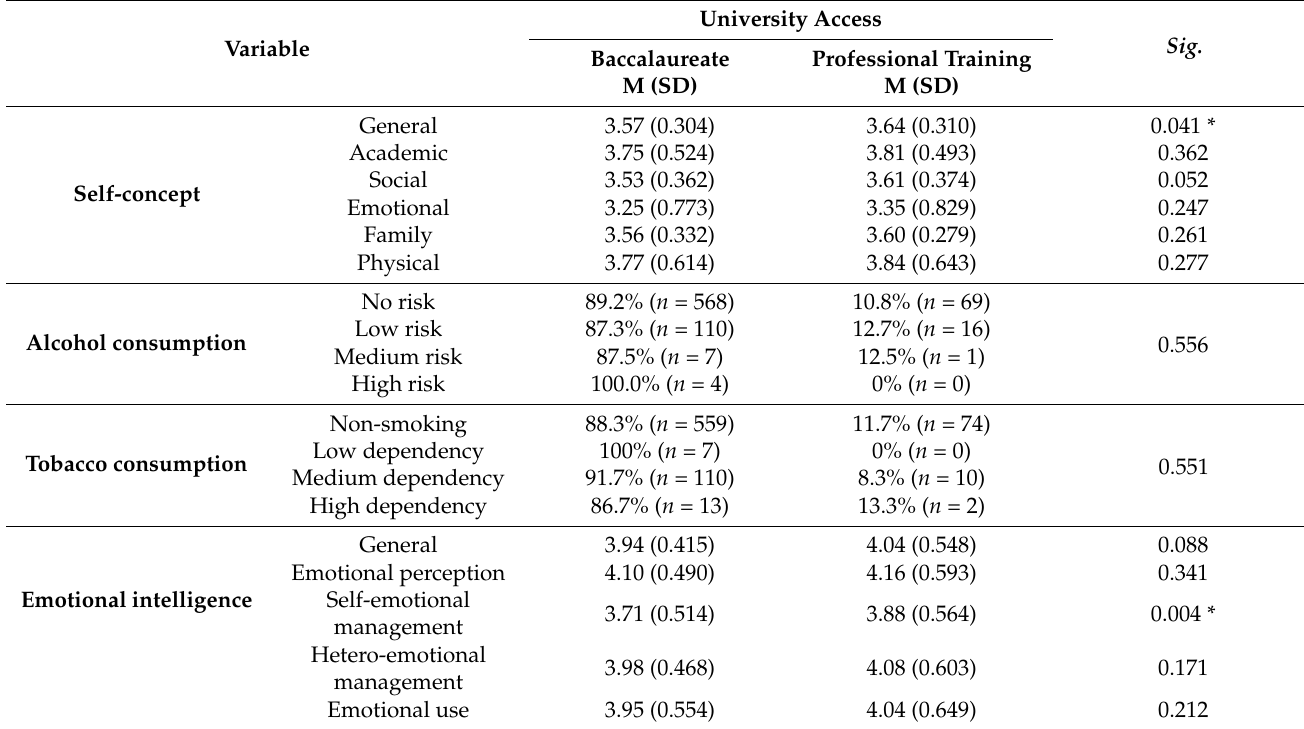
Table 2. Psychosocial factors according to university access.